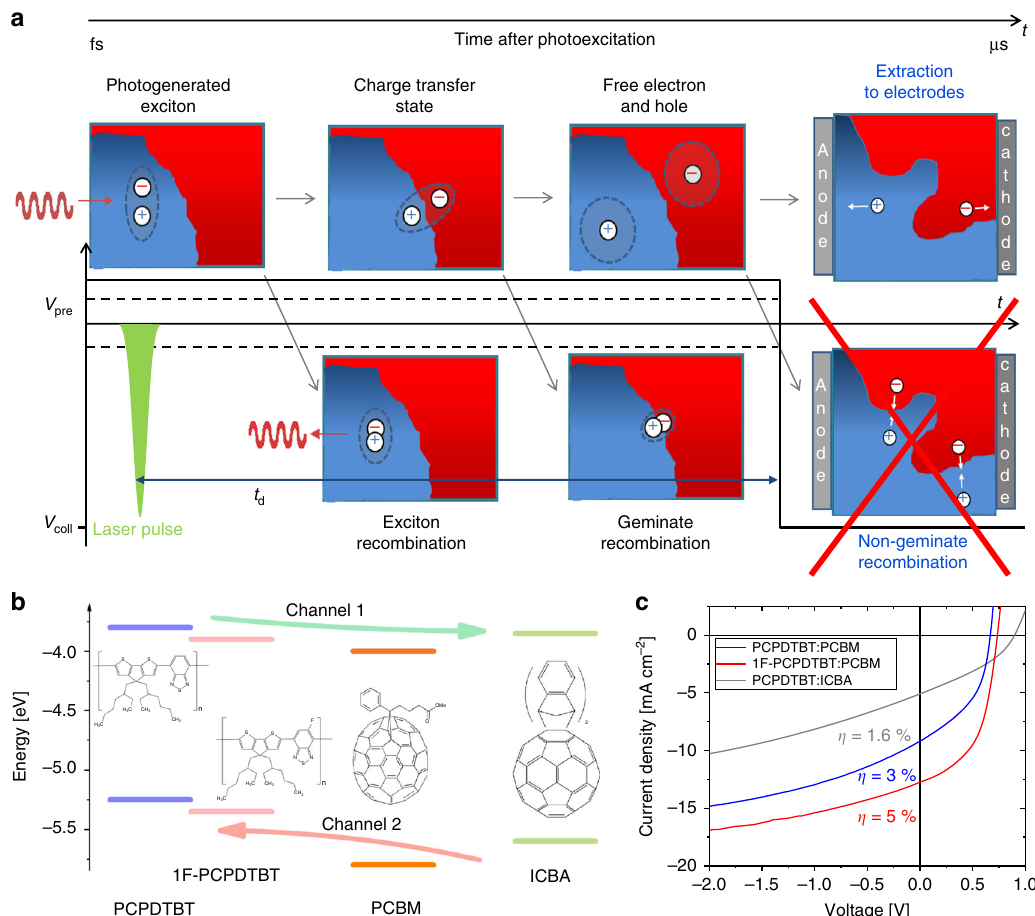
Fig. 1 Scheme of the TDCF method, energy level diagram and device performances: a Scheme of the elementary excitations and processes involved in absorbed photon-to-electron formation. Geminate and non-geminate recombination occur at different time scales at AM1.5G-relevant carrier densities. Therefore, applying a strong reverse bias in TDCF prior to the onset of non-geminate recombination allows free charge formation due to the separation of CT states to be measured. b Energy level diagram for the materials used in this study. Arrows indicate the pathways of charge formation via electron (channel 1) or hole transfer (channel 2) across the donor-acceptor heterojunction. The energy offset at the heterojunction is reduced by substituting PCBM with ICBA or PCPDTBT with 1F-PCPDTBT. c Current voltage characteristics of the studied blends with a thickness of approx. 110 nm under simulated AM1.5 G illumination. As expected, increasing the energy of the charge separated state (by either lowering the polymer HOMO and/or heightening the acceptor LUMO) increases the V oc , but there is no trivial connection between the energetics of the blend and the overall device measurement of the photogenerated free charge density. In all